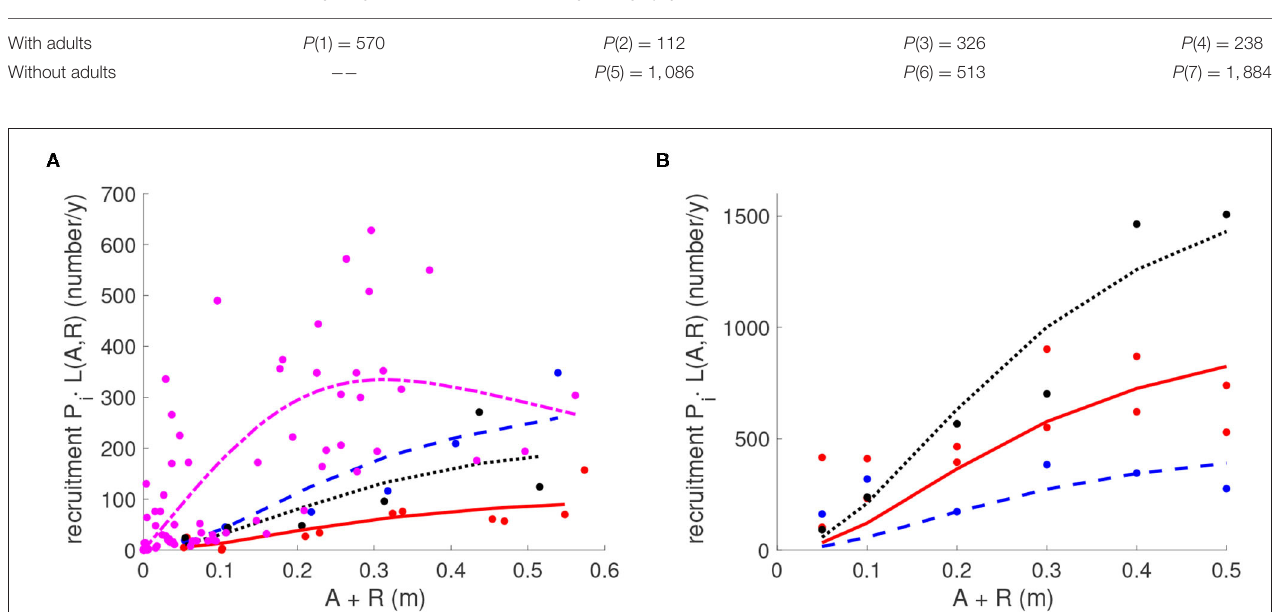
FIGURE 5 | Statistical fitting of the larval production P and recruitment function L ( A , R ). For each site i , yearly recruitment P i L ( A , R ) is shown. (A) Reefs with live adults A and dead shell R present; (B) Reefs with only dead shell R present and where A = 0. Red: Great Wicomico River sites GWR1 and GWR2; Purple: GWR3; Blue: Linkhorn Bay site, LB; Black: Broad Bay site, BB. Parameter values are in Tables 2 , 3 .